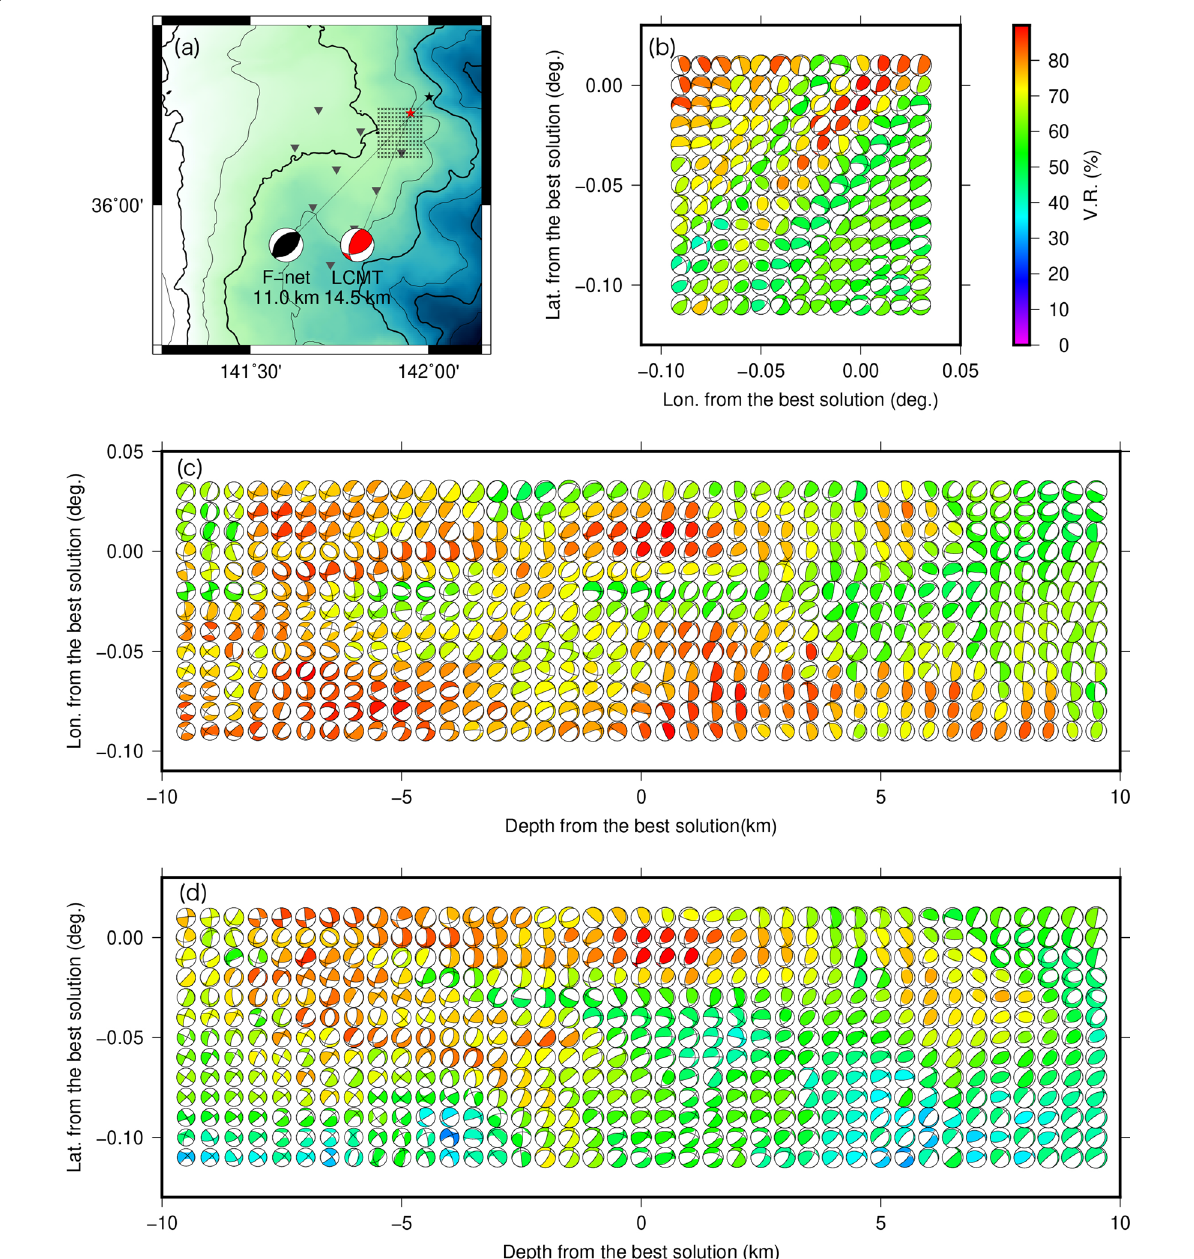
Fig. 10 Result of the CMT inversions for the earthquake that occurred at 9:06, March 16, 2011 (JST), using sparse OBS stations. Notations are the same as Fig.